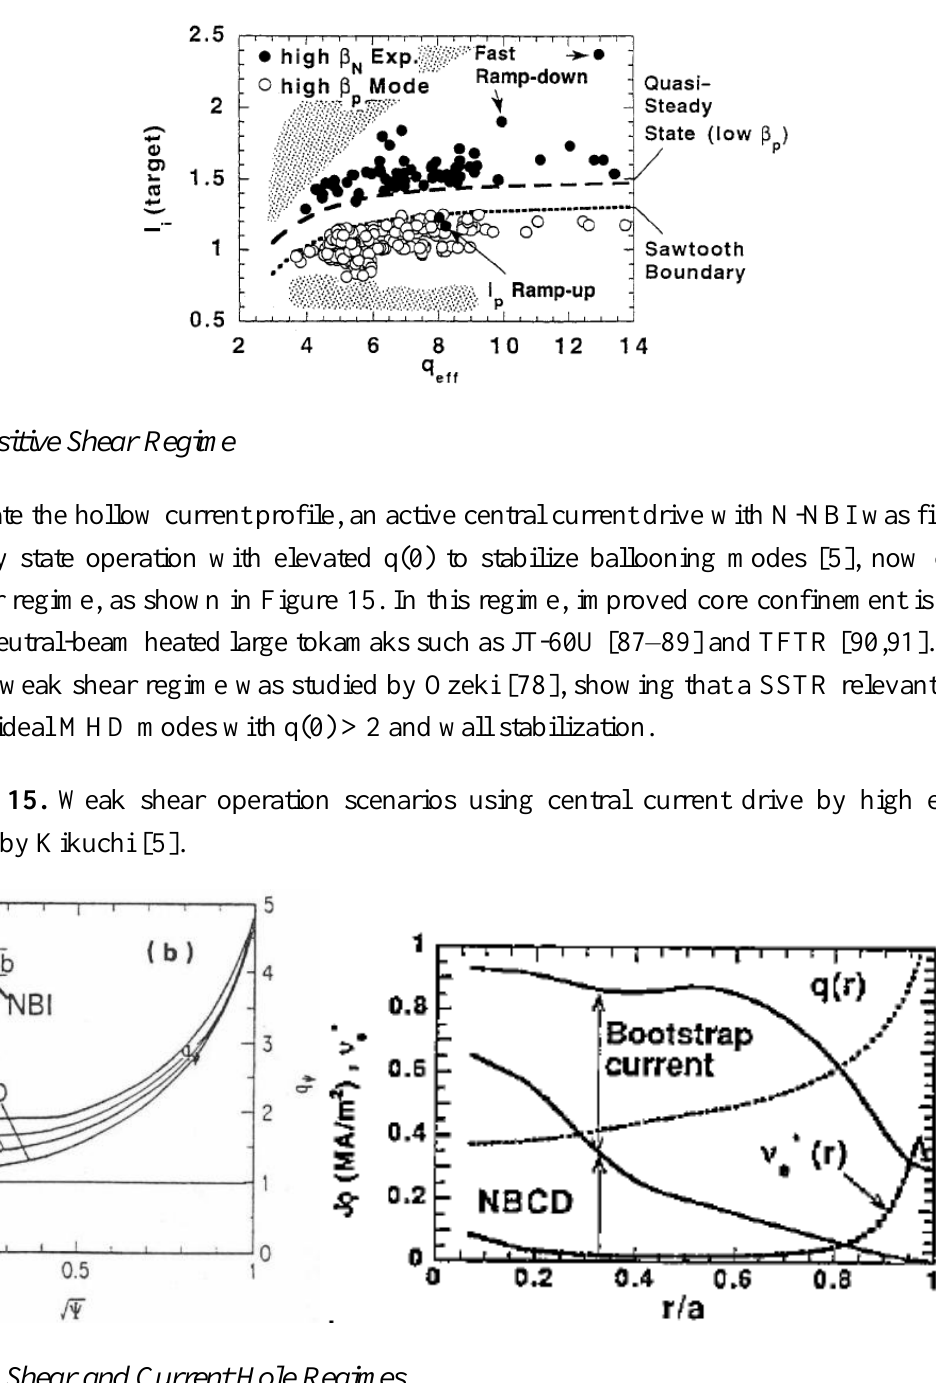
Figure 14. The (q experiments by Kamada [86]. Here, q